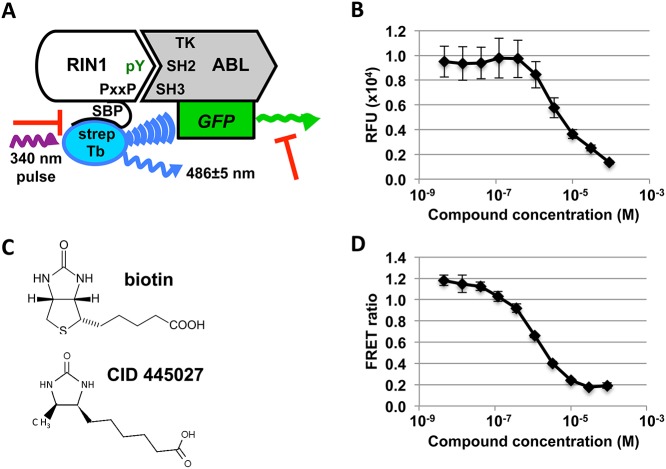
Elimination of off-target inhibitors.(A) Two types of off-target inhibitors were predicted (red T-bars): compounds that quench GFP fluorescence, and biotin-like compounds that bind and sequester streptavidin. (B) Hit compounds were tested in triplicate dose-response curves with ABL-eGFP. Concentration response curve data from a representative GFP quencher (methyl 3,4,6-trihydroxy-5-oxo-5H-benzo[7]annulene-8-carboxylate) is shown. (C) Biotin mimics were identified by in silico screening for structural similarity to biotin. (D) Hit compounds were re-tested in the TR-FRET assay in triplicate 10-point dose-response curves to prioritize those with IC50<10 μM. Data from the representative compound CID 24512426 is shown.